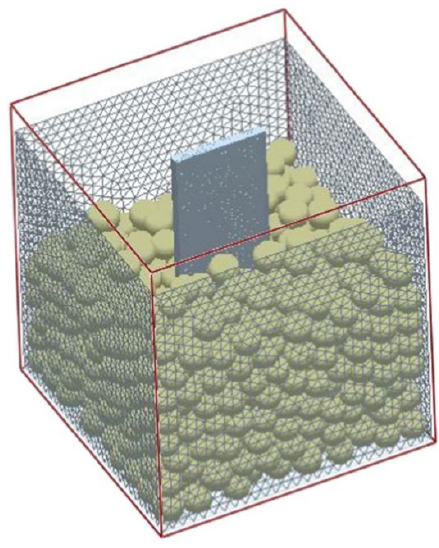
Figure 26. Hybrid FEM-BEM-DEM process for acoustic abrasive Polishing [165].